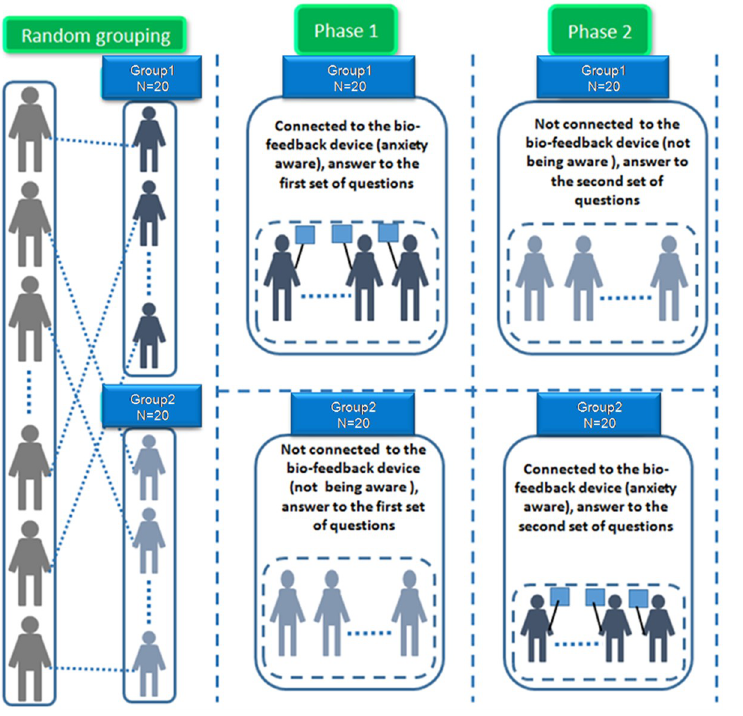
Fig 3. The activity procedure (student groups and